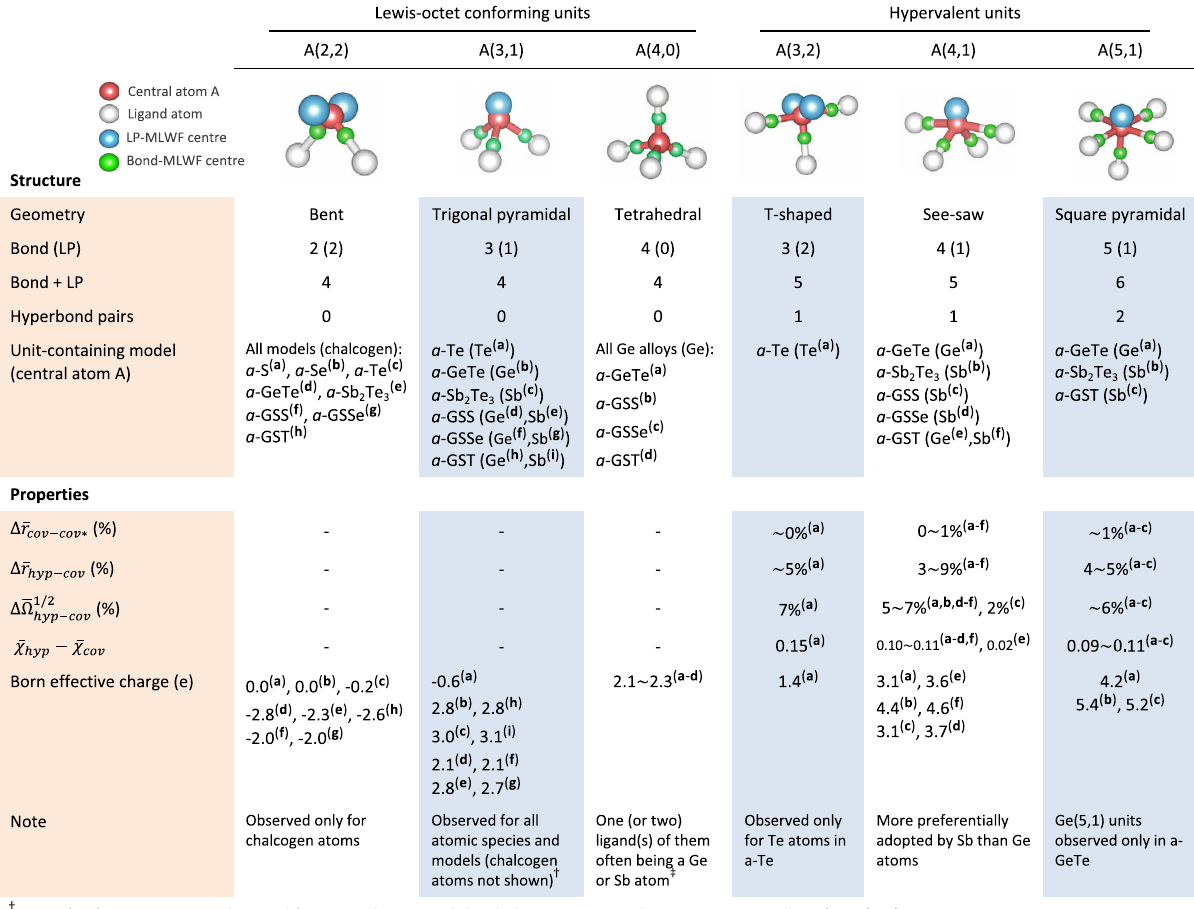
Fig. 3 Summary of structural units and their properties in amorphous chalcogens and chalcogenides. Structural units are classi fi ed as either a Lewis- octet-conforming unit or a hypervalent unit, depending on whether the sum of their associated numbers of bonds and lone pairs (LPs) is four (octet- conforming units) or more than four (hypervalent units). The positions of MLWF centres, representing either a bond (green) or LP (cyan), are speci fi ed for each type of structural unit. Also, for each type of structural unit, a list of models that contain the units in their structure is shown (in the upper panel), together with their corresponding chemical-bonding properties (in the lower panel). The over-strike bar indicates the mean value for the corresponding observables. (cid:1) r hyp ( (cid:1) r cov ) denotes the mean bond length of hyperbonds (covalent bonds) for hypervalent units, whilst (cid:1) r cov (cid:1) indicates the mean bond length of covalent bonds for (2,2)-type units for a -Te or for (3,1)-type units for the other models. Δ (cid:1) r cov (cid:3) cov (cid:1) stands for the difference between (cid:1) r cov and (cid:1) r cov (cid:1) in (cid:1) (cid:3) (cid:1) r ´ 100. Δ (cid:1) r fi es a difference between (cid:1) r percentage, which is calculated by the equation, (cid:1) r cov = (cid:1) r cov (cid:1) (cid:3) 1 hyp (cid:3) cov signi hyp and cov for the unit, that is, (cid:1) r the ionicity of a bond. For homopolar bonds, (cid:1) χ is supposed to be 0.5, and (cid:1) χ values larger than this value indicate the degree of charge transfer of bonding electrons to a ligand. The Born effective charge (BEC, or Z *) tensor was calculated for the central atom of each structural unit, and one-third of its trace was taken as the BEC value representing each structural unit. The superscripts a – i specify a correspondence between an atomic species (A) of a material (upper panel) and the bonding properties of its associated structural unit or BEC (lower